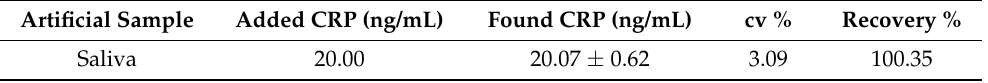
Table 1. Recovery% of CRP in artificial saliva with PS/rGO-MNP-PDA/Anti-CRP immunosensor (n = 9).